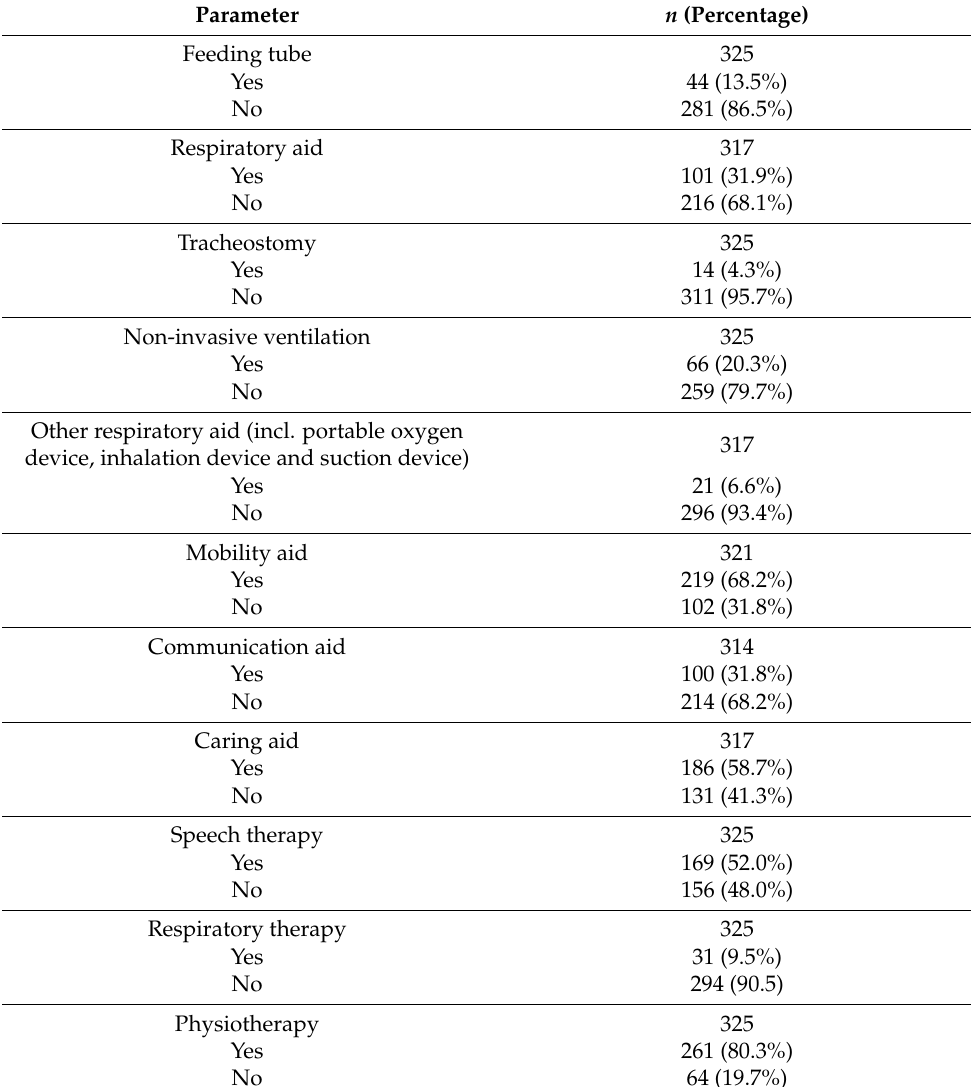
Table A1. Patient characteristics: aids, therapies and medications. Table showing the number of different patients using the various aids, therapies and medications, including tracheostomy, non-invasive ventilation and a mobility aid. Abbreviations: n ,